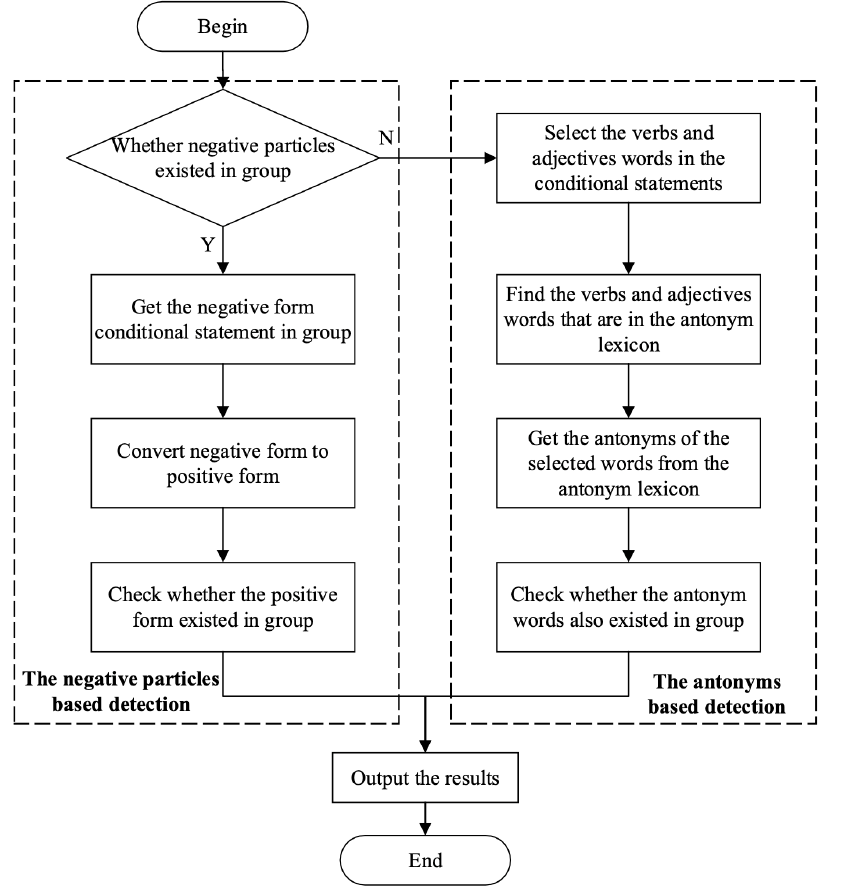
Figure 4. The process of the requirements incompleteness